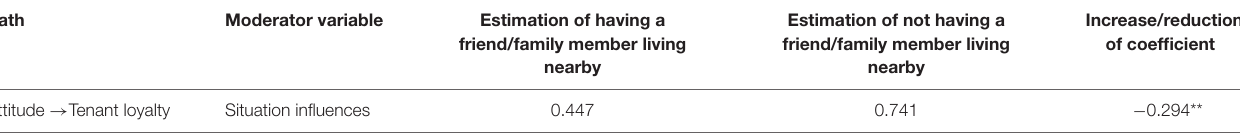
TABLE 6 | Path analysis of the moderator